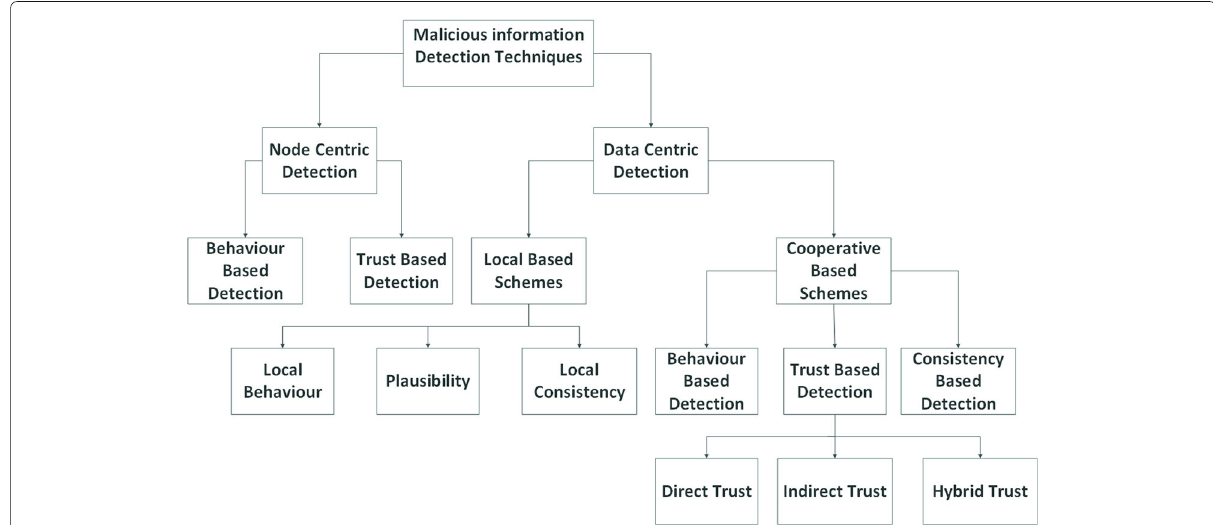
Fig. 3 Malicious information detection schemes in